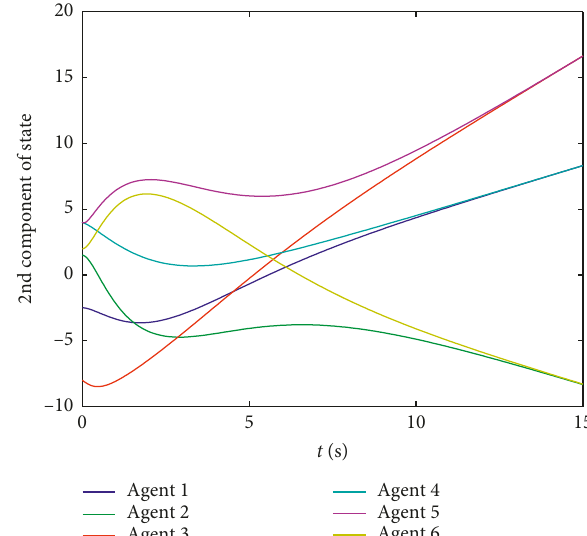
Figure 6: Trajectories of x